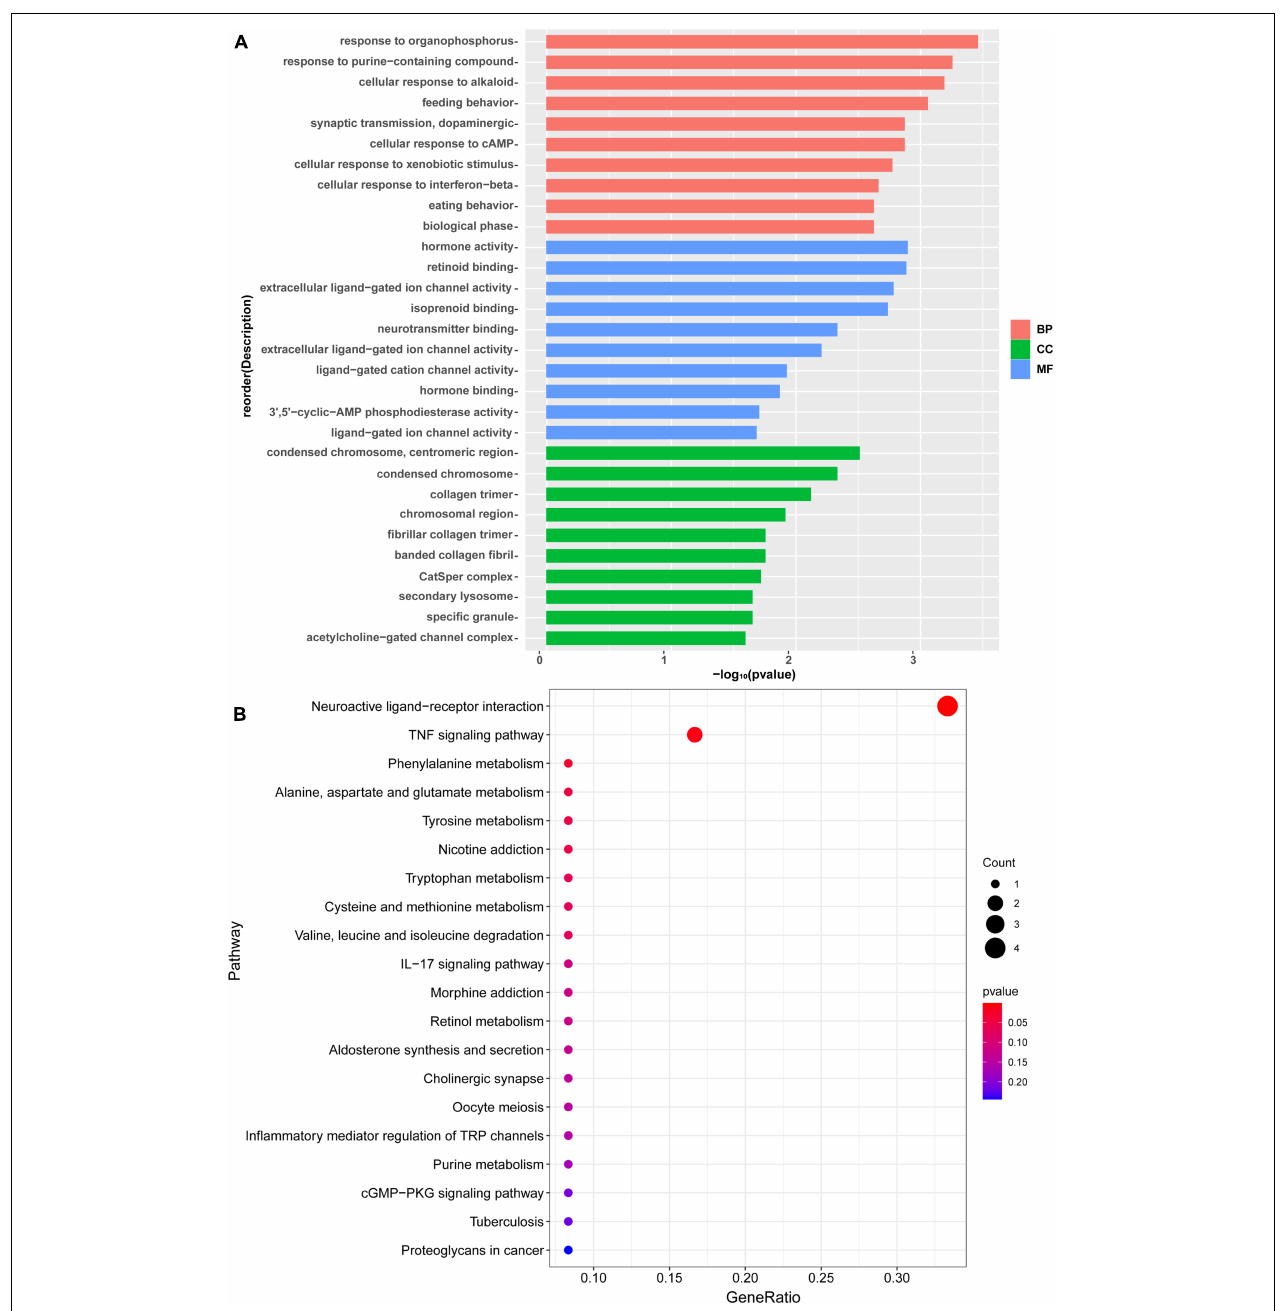
FIGURE 4 | (A) A Gene Ontology (GO) analysis of differentially expressed gene. The enrichment score was calculated as (–log 10 [P value]). The X -axis is the enrichment score for the GO terms, and the Y -axis depicts the GO terms. Pink represent top 10 enrichment score of biological process. Green represents top 10 enrichment score of cellular component. Blue represents top 10 enrichment score of molecular function. (B) KEGG pathway analysis of differentially expressed with the top 20 enrichment scores. The X -axis represents the gene radio, and the Y -axis shows the name of these